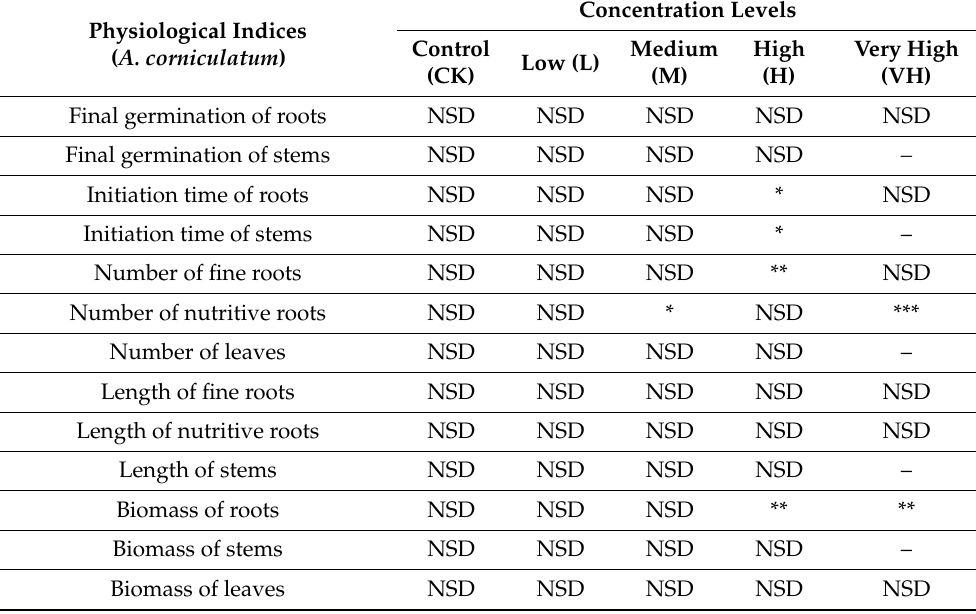
Table 2. Distinguishing effects between LLL and PCT treatments from K. obovata on physiological performance of A. corniculatum using the T-test method. Note: * p < 0.05, ** p < 0.01, and *** p < 0.001; NSD means no significant difference; – denotes no comparison, since no stems or leaves were